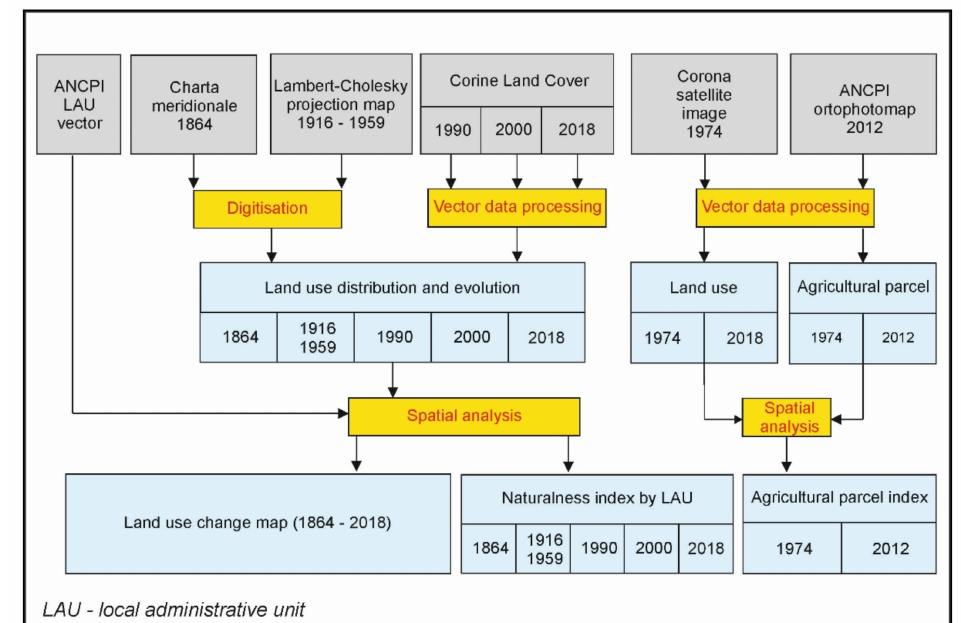
Figure 2. Methodological